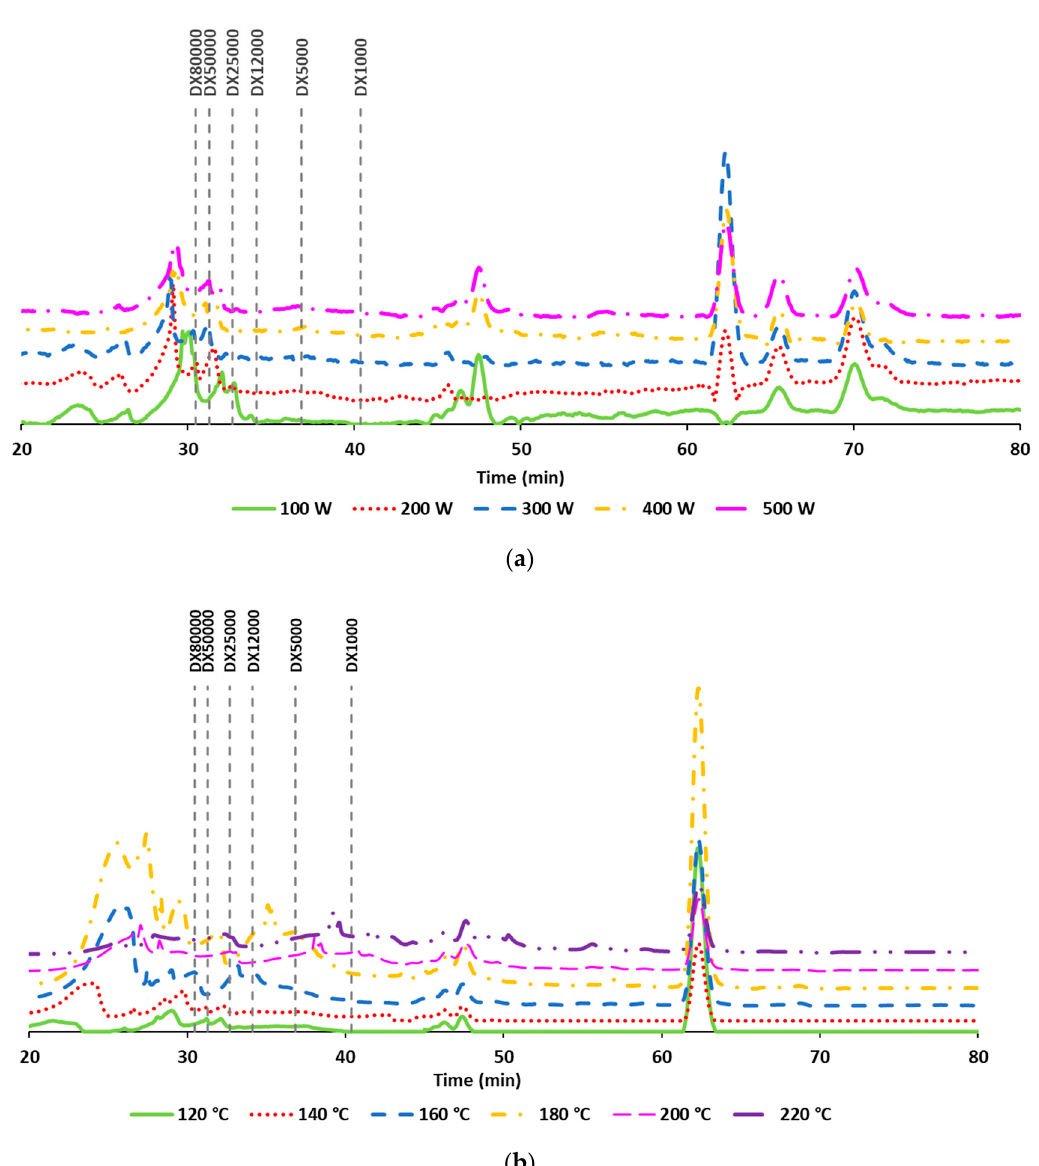
Figure 5. Molar mass distribution of the liquid samples obtained by microwave hydrodiffusion gravity-UAE at different powers ( a ) and autohydrolysis (AH) at different final heating temperatures ( b ).